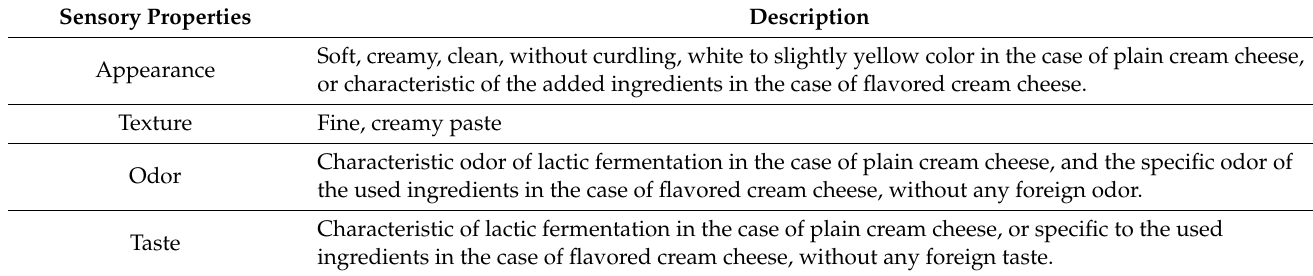
Table 8. Sensory characteristics of the cream